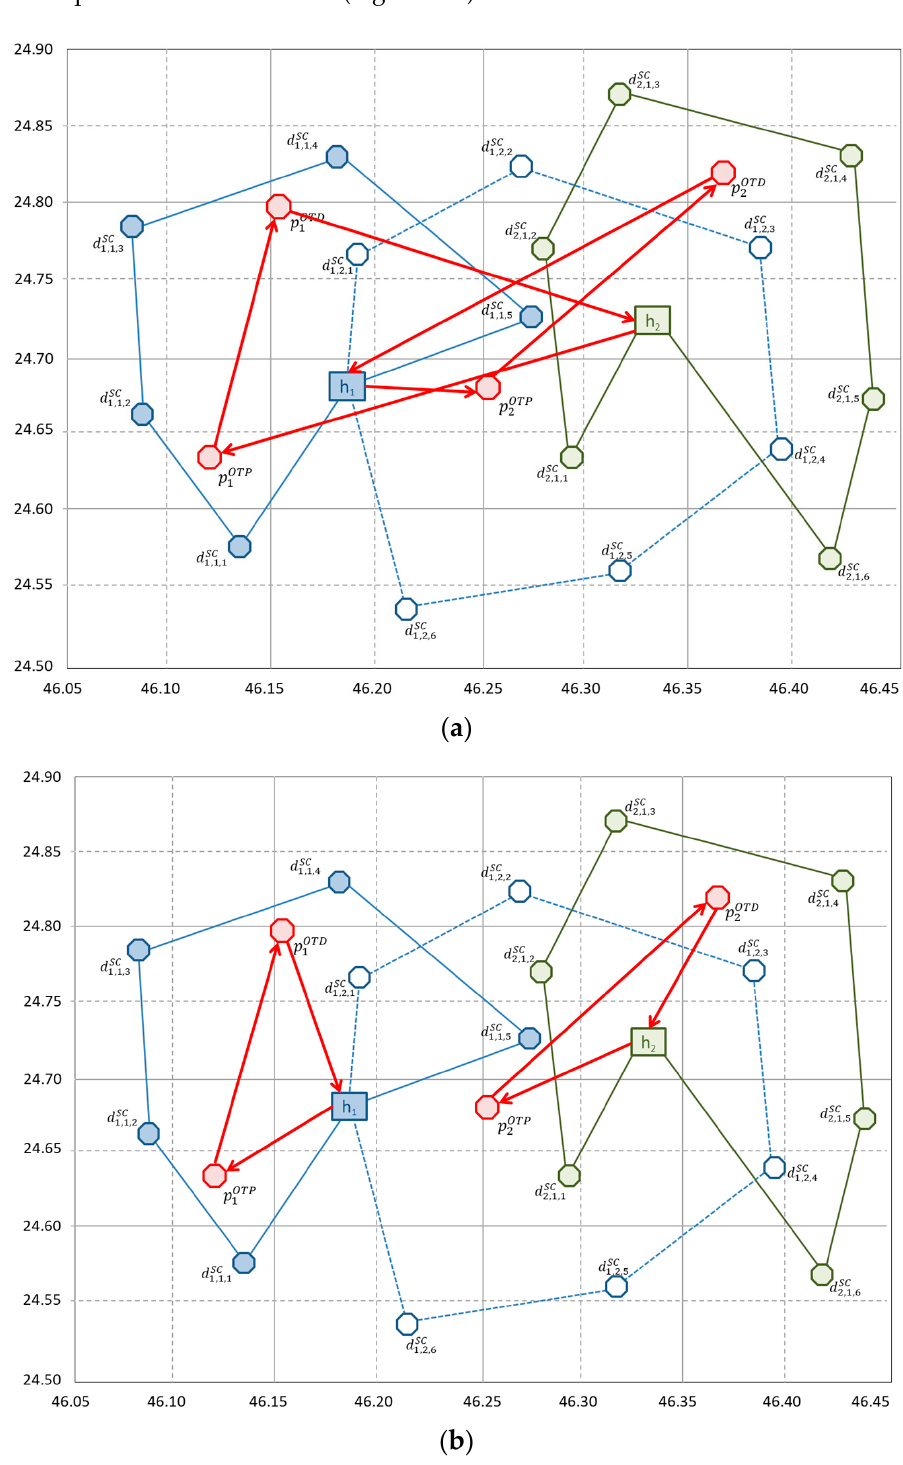
Figure 12. Scheduled routes and shuttle services in Scenario 1 and 2: ( a ) The open tasks are assigned to the parcel delivery service provider (PDSP) receiving the task; ( b ) The open tasks are assigned to the optimal PDSP.